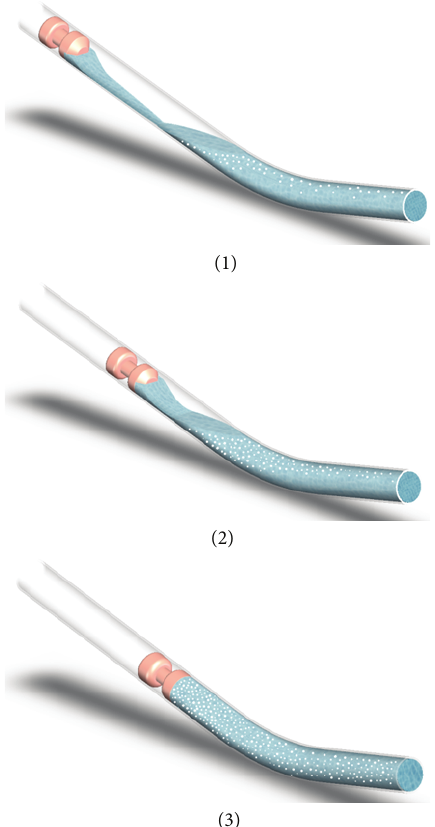
Figure 1: Schematic diagram of collapse of a cavity by a